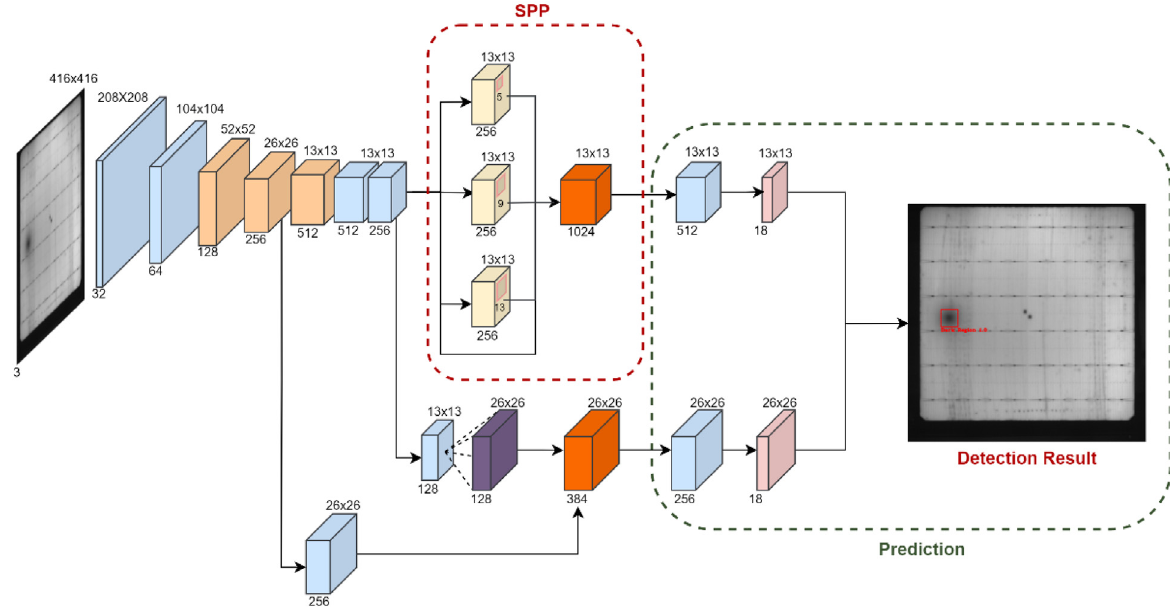
Fig. 8. Modi fi ed single class Tiny-YOLOv4 with SPP extractor.